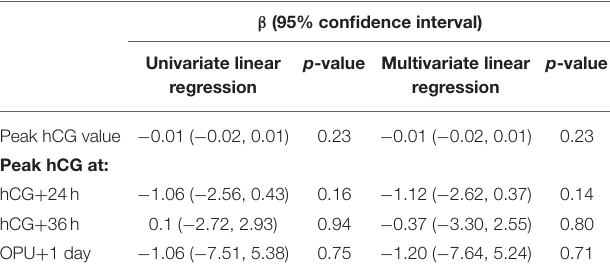
TABLE 4 | Correlations between peak serum human chorionic gonadotropin (hCG) concentration and the number of follicles of ≥